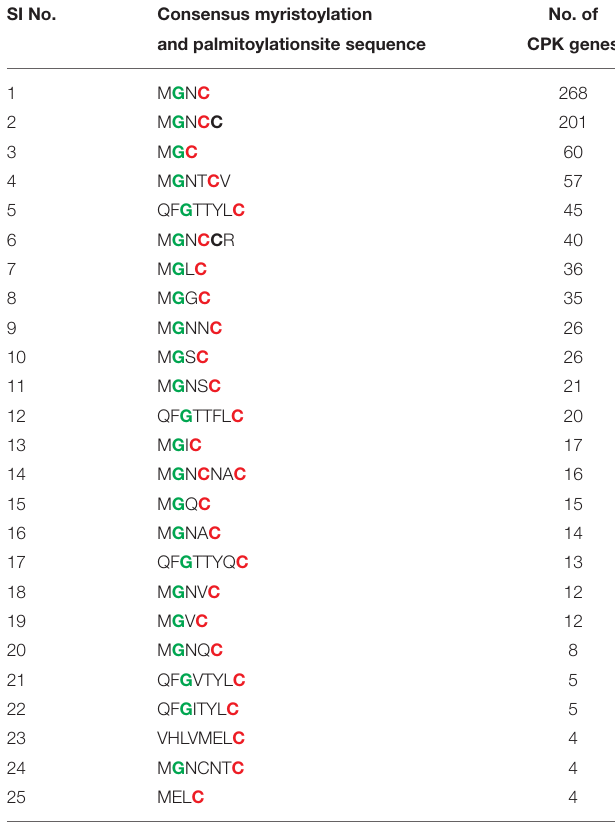
TABLE 3 | Protein myristoylation and palmitoylation are important post-translational modification events required for sub-cellular targeting of CPKs. SI